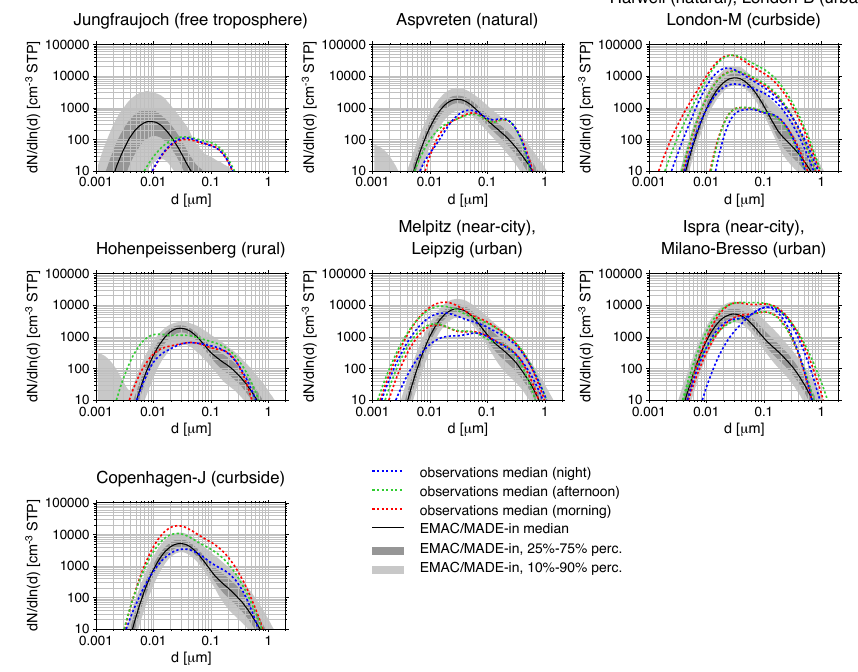
Fig. 12. Aerosol number size distributions at surface level as observed at different sites in Europe (Putaud et al., 2002) during winter (December, January, February) and corresponding model size distributions. The observed size distributions are three-modal log-normal distributions fitted to the measurements data. The simulated number size distributions are climatological medians of 10yr calculated for the location and months of the observations.